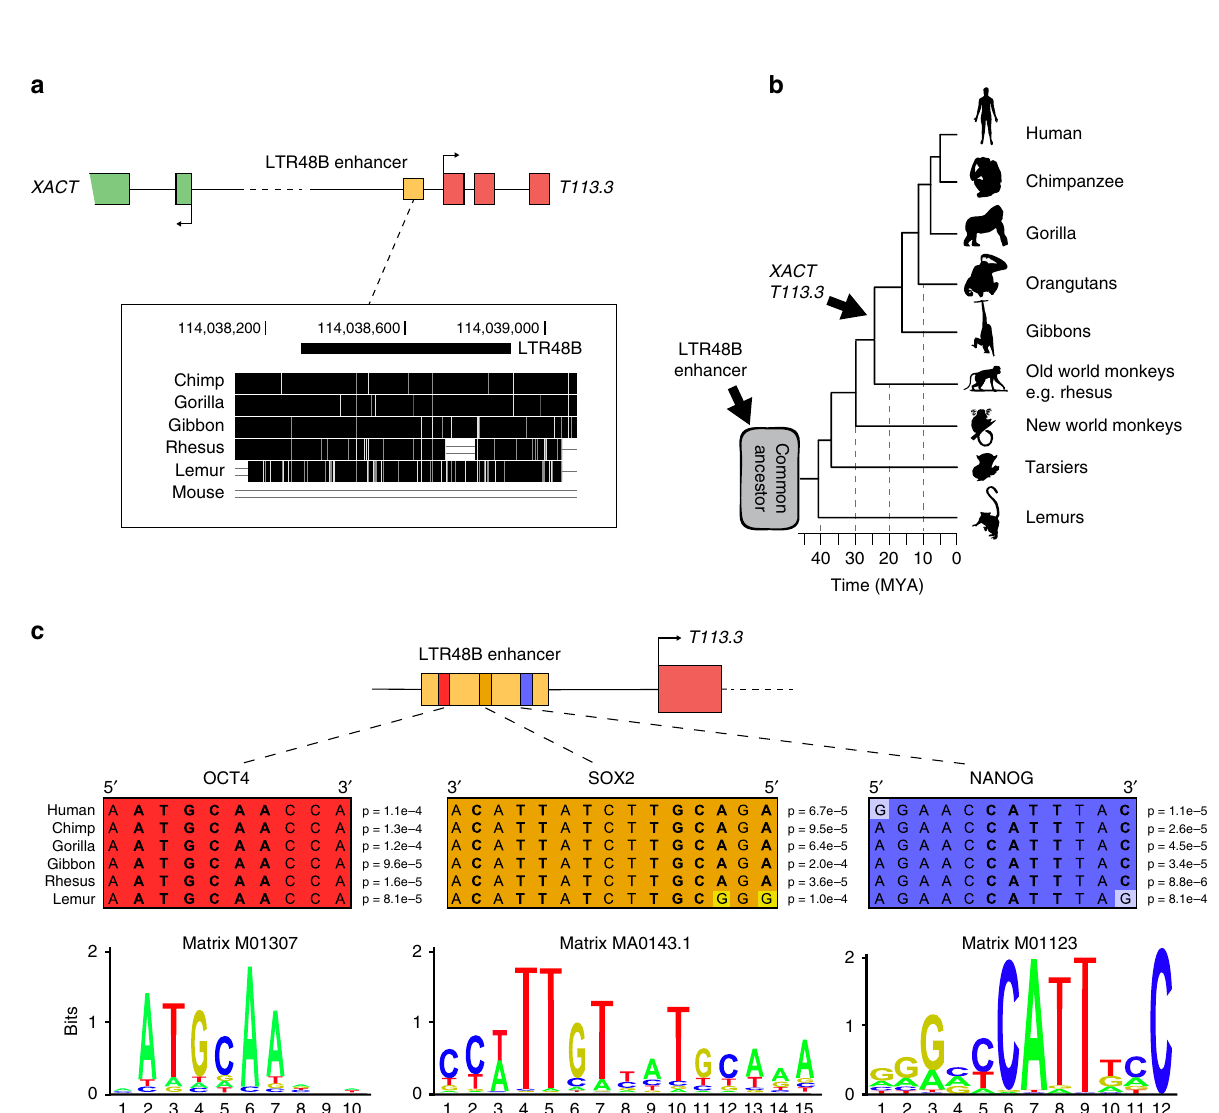
Fig. 5 A common enhancer wires the XACT / T113.3 locus to the pluripotency network. a ATAC-seq (black) and ChIP-seq data for H3K4me3, H3K27ac (blue), CTCF (brown), OCT4, SOX2, and NANOG (orange) enrichment over the T113.3 TSS region in H1 hESCs. Publicly available data were obtained from the ENCODE project 57 and CISTROME DB 45 . Called peaks for CTCF, OCT4, SOX2, and NANOG are shown as black rectangles. b Scheme of the T113.3 locus showing the guide positions (black arrows) used for targeting either the CTCF (top panel) or TFB (bottom panel) sites upstream of the T113.3 gene. Quantitative RT-PCR analysis of XACT (left) and T113.3 (right) expression in CTCF- (top panel) or TFB- (bottom panel) targeted hESCs. The bar charts correspond to the average of at least two independent clones. c KD ef fi ciency of SOX2 , OCT4 , and NANOG using an siRNA approach was assessed by western blotting. H1 hESCs were used as a non-transfected control cell line (no_si). siSCR was used as a non- targeting siRNA. Tubulin and H3.3 were used as loading control. d Quanti fi cation of XACT (top bar chart) and T113.3 (bottom bar chart) steady-state RNA levels by RT-qPCR in cells transfected with siRNAs targeting SOX2, OCT4, NANOG, or a combination of siRNAs targeting both OCT4 and SOX2. Error bars indicate the SD. Statistical signi fi cances were determined using a one-way ANOVA (all conditions compared with WT). * P -values < 0.05, ** P -values < 0.01, *** P -values < 0.001, and **** P -values < 0.0001.